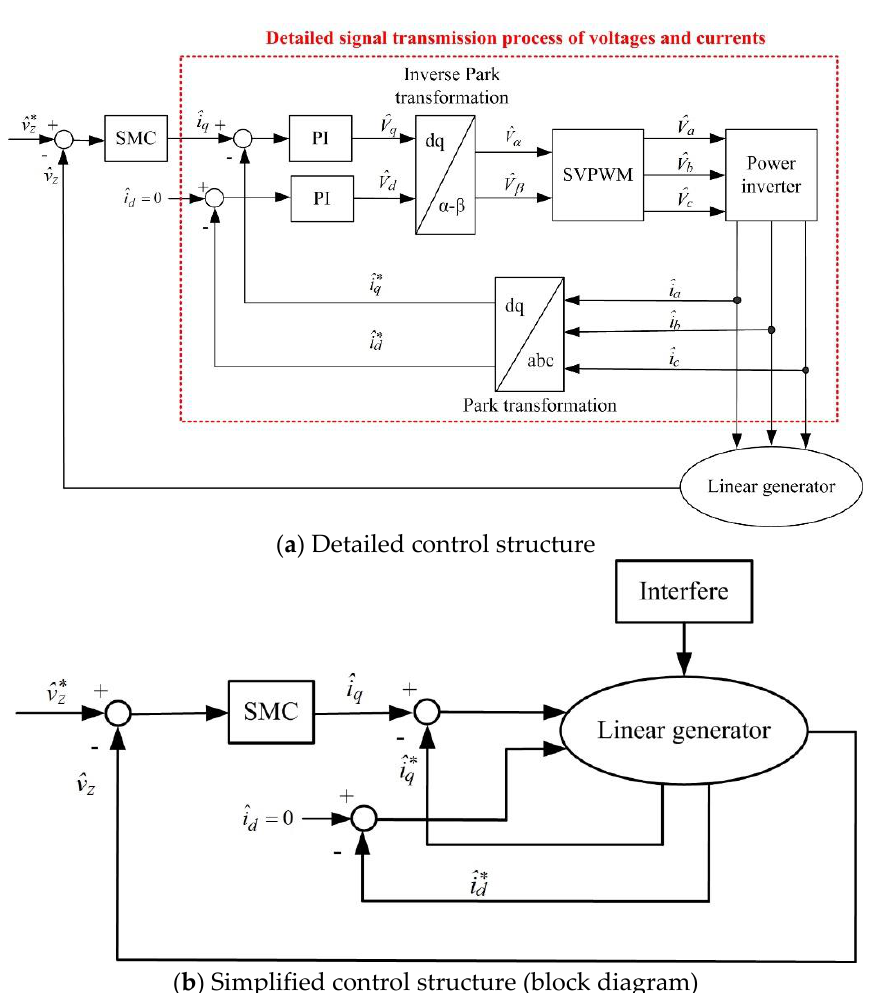
Figure 10. The control structure of double-buoy OWECS.